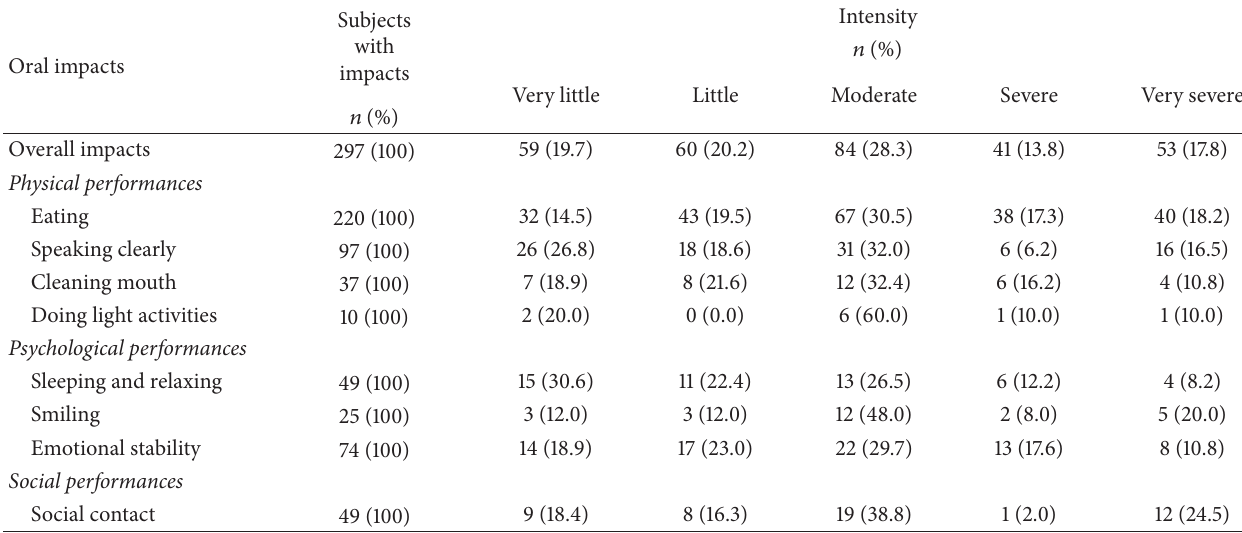
Table 2: Intensity of oral impacts among 812 Thai older